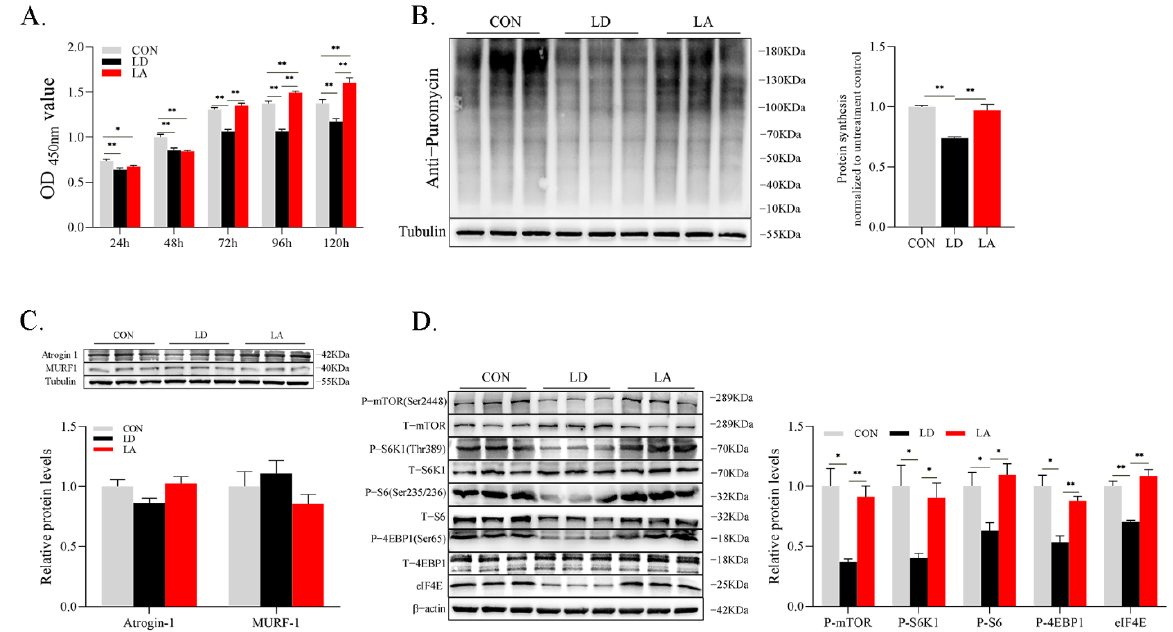
Figure 3. Lysine deficiency attenuates SCs proliferation, protein synthesis, and phosphorylation levels of the mTORC1 signaling pathway. ( A ) Cell proliferation; ( B ) representative images of cell protein synthesis levels with Western blotting; ( C ) representative images of protein ubiquitination level marker protein atrogin1 and MuRF1 expression levels with Western blotting; ( D ) representative images of phosphorylation levels of mTORC1 signaling pathway-related proteins with Western blotting. * p < 0.05, ** p < 0.01. The data shown represent mean ± SEM of three independent experiments ( n = 3).